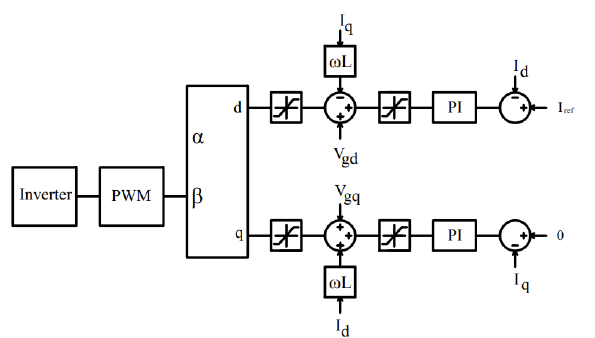
Figure 15. The block diagram of the inverter controller—grid-tied operation